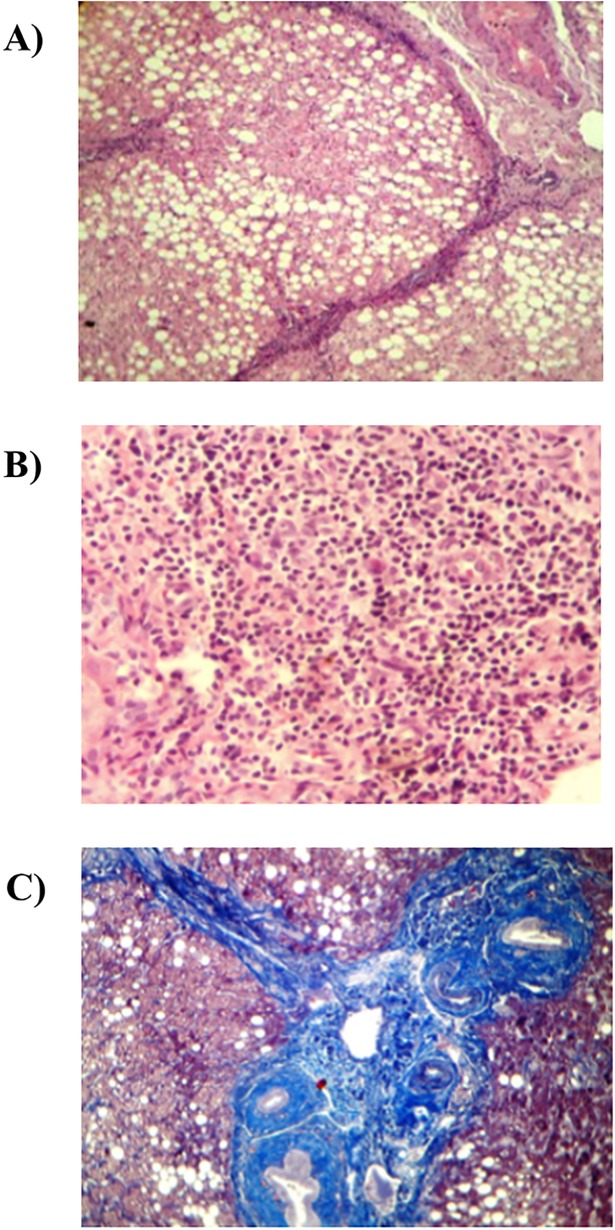
Representative images of histological staining of liver biopsy.A) Steatosis grade was evaluated using Periodic Acid-Schiff (PAS). B) The necroinflammatory grading comprised the presence of steatosis, ballooning, and inflammation evaluated by PAS and H&E. C) Masson´s trichrome stain was used to reveal fibrosis and architectural changes.